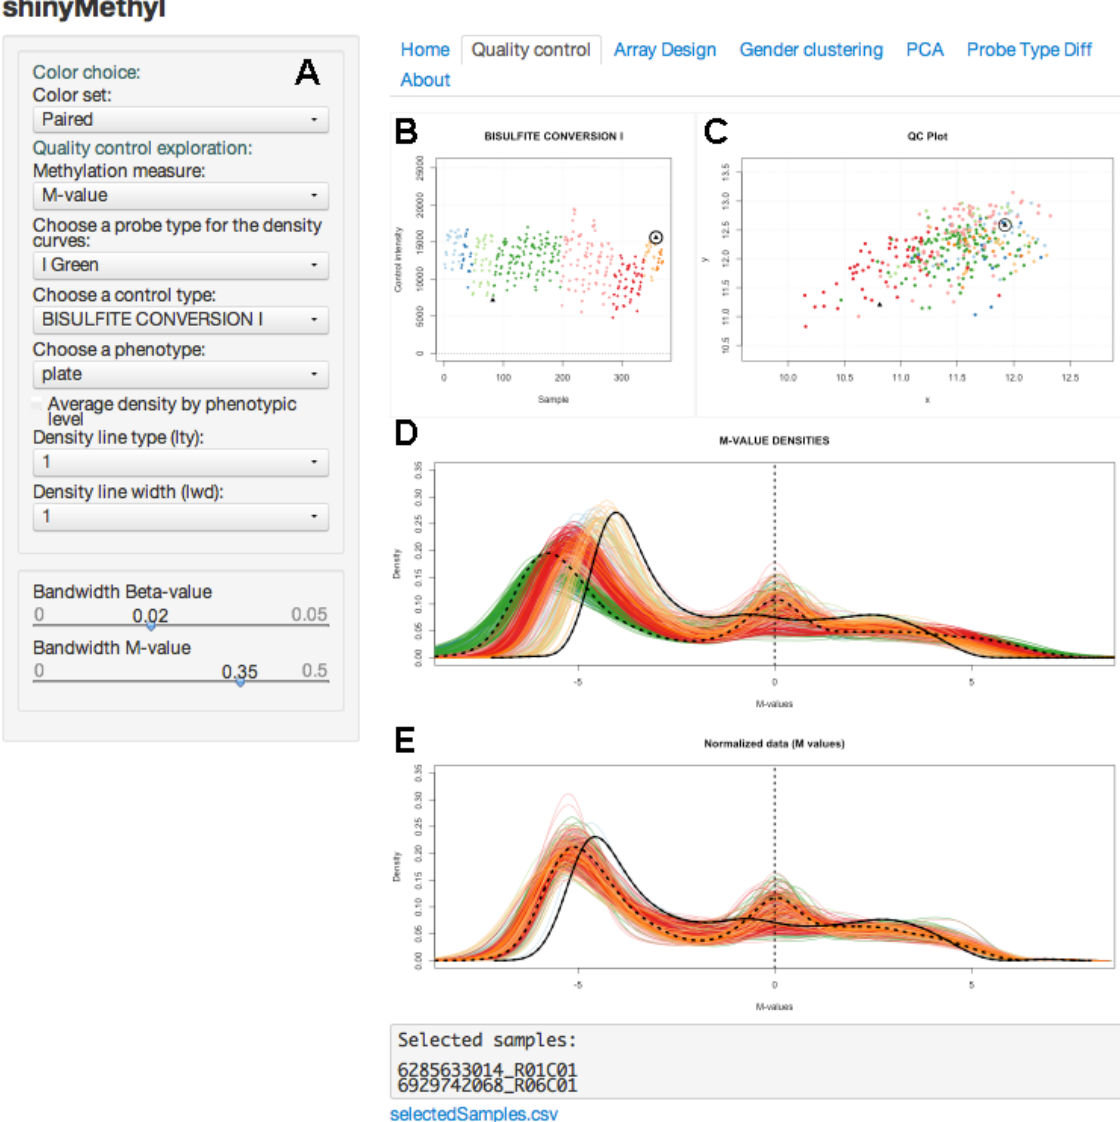
Figure 2. The shinyMethyl user interface for quality control. The interface shows an example interactive visualization of batch effects and quality control (TCGA head and neck squamous cell carcinoma, HNSCC dataset). The interface is divided into a user menu and a plotting area. ( a ) A menu containing a number of user-settable visualization parameters. The “phenotype” is set to “plate” which makes the color scheme reflect batch. The four plots ( b – e ) are interactive and react simultaneously to the user mouse clicks, so that samples selected on one plot are immediately highlighted on the additional plots. The solid lines in black represents the sample(s) currently selected by the user and match the dot circled in black on ( b , c ). The dashed lines in black represents another sample, previously selected by the user and match the black dot without the circle. ( b ) Average negative control probes intensities; ( c ) the median intensity of the M channel against the median intensity of the U channel; ( d – e ) M-value densities for Infinium I probes before and after functional